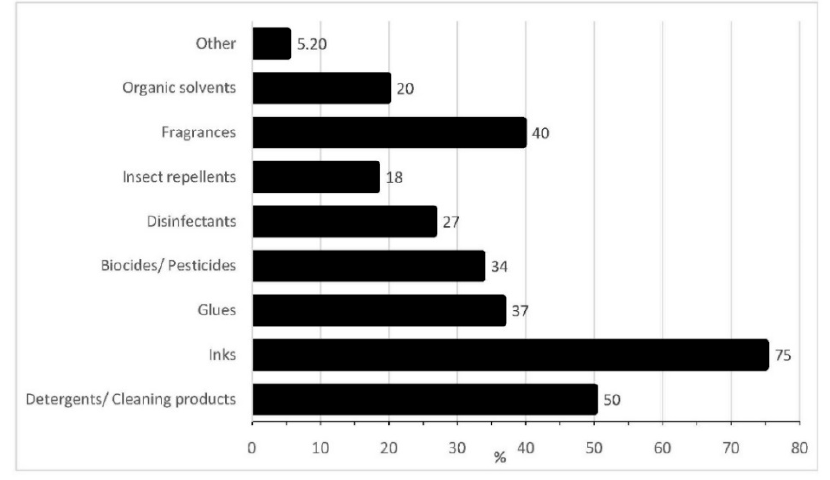
Figure 1. Popular chemicals used by children.